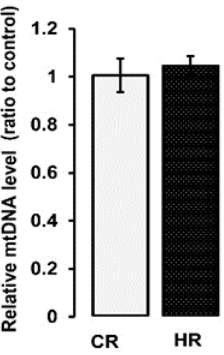
Figure 1. The relative mtDNA levels in the HM of animals. A real-time qPCR was carried out to determine the mtDNA copy number, which is calculated as the ratio of mitochondrial DNA (tRNA) to nuclear DNA (GAPDH) ( n = 5 in each group). CR-control, HR-hyperthyroidism.